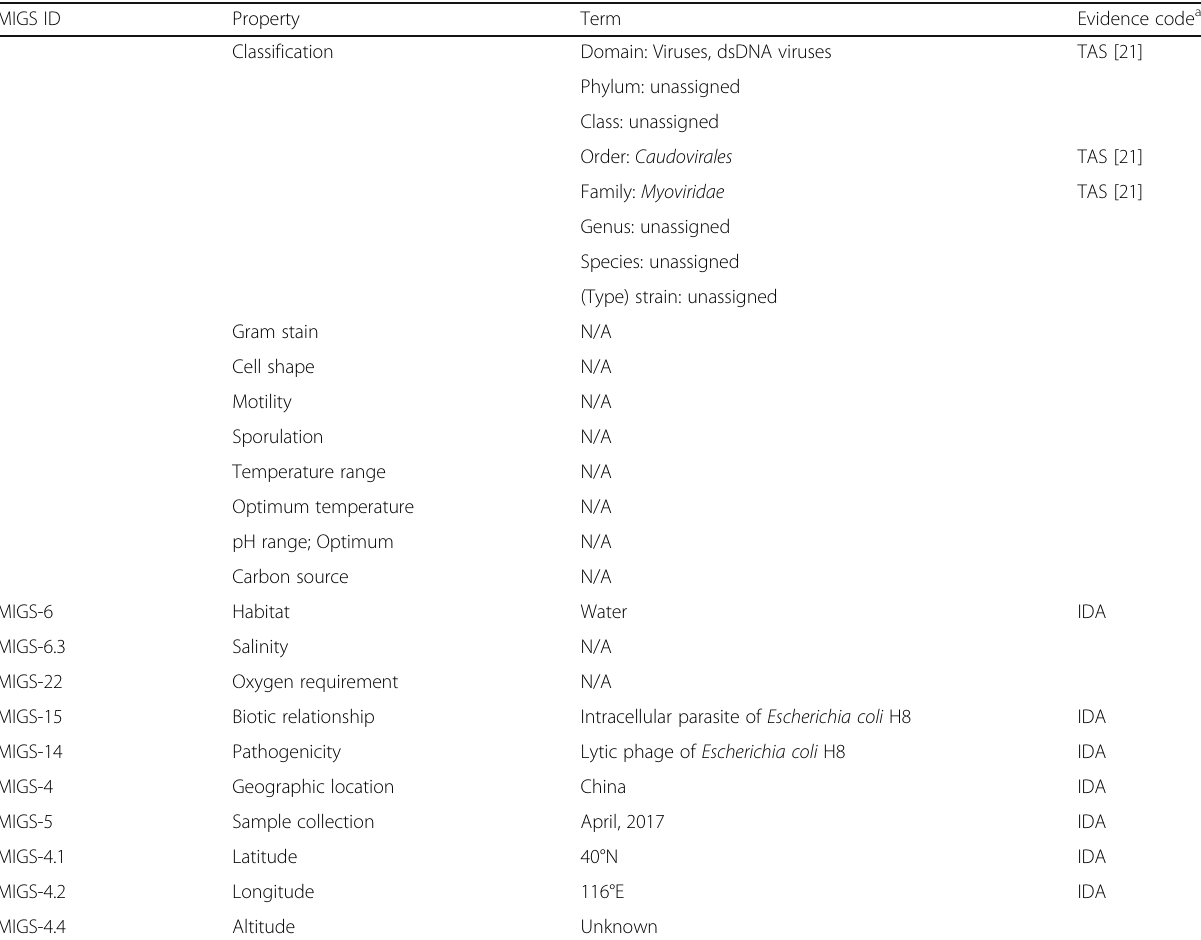
Table 1 Classification and general features of Genusspecies strain designation T [19] MIGS